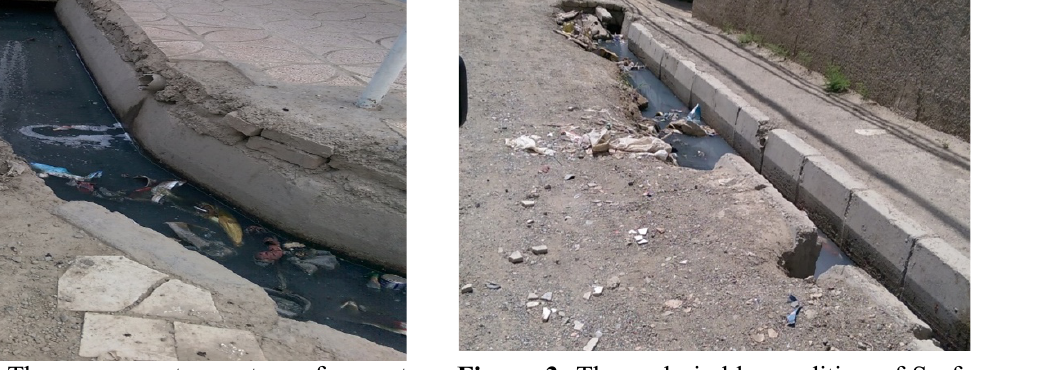
Figure 2. The sewage entrance to surface water collection channels